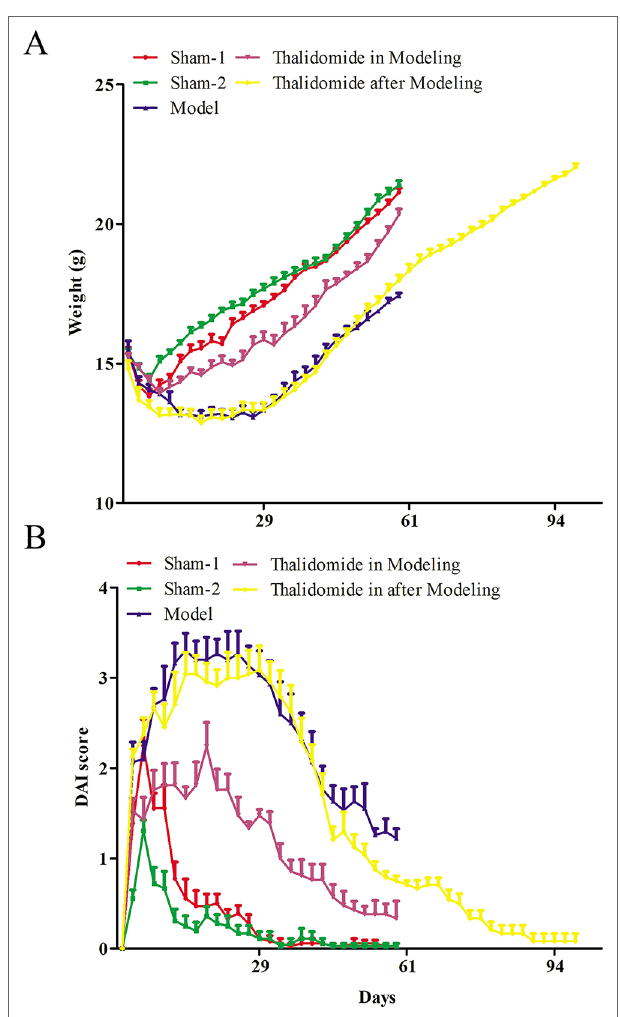
FIgURe 1 | Effects of thalidomide on the body weight and DAI in mice induced with TNBS. (A) The body weight of mice from different groups. (B) The DAI score of mice from different groups. The results were expressed as the mean ± SD.